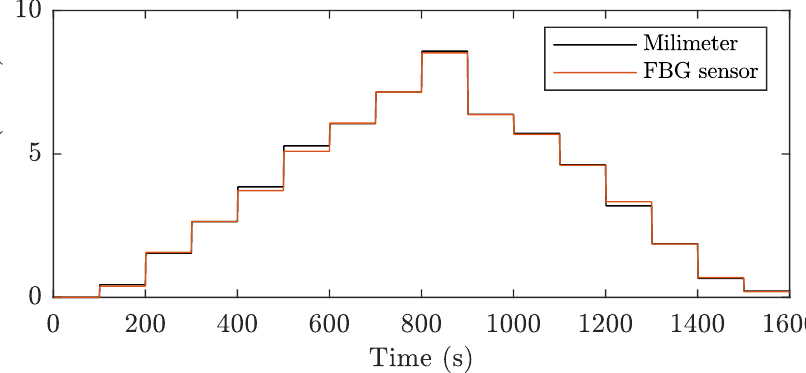
Figure 9. Comparison of one pressure measurement cycle with a millimeter reference pressure gauge and diaphragm FBG